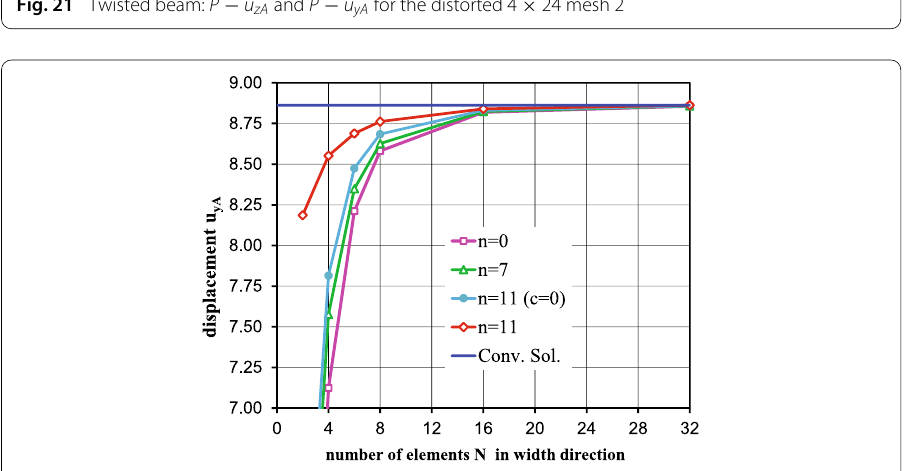
Fig. 22 Twisted beam: u yA − N for distorted mesh 2